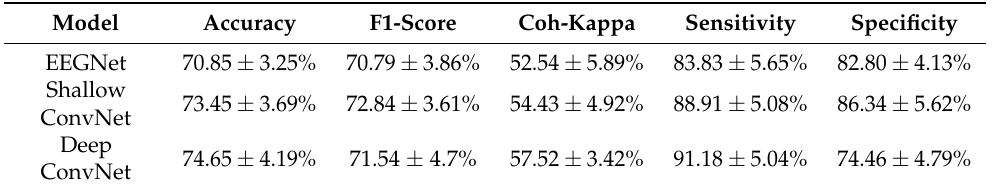
Table 5. LOSO Classification performance for transition to FOG vs. transition to voluntary stopping vs. normal